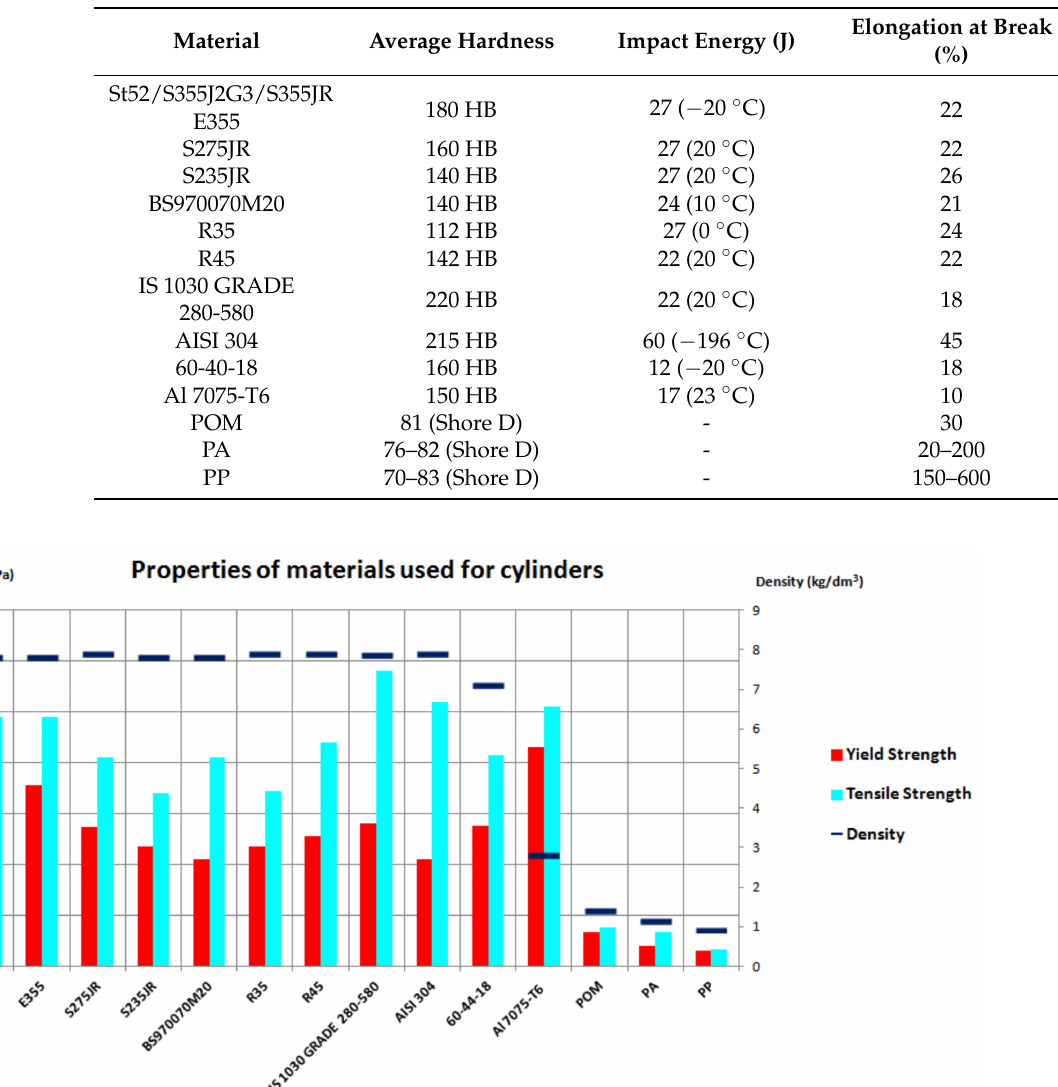
Table 2. Additional properties of the materials used for cylinders.